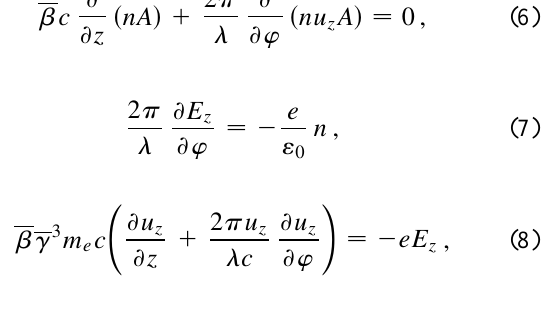
TABLE I. Accelerator